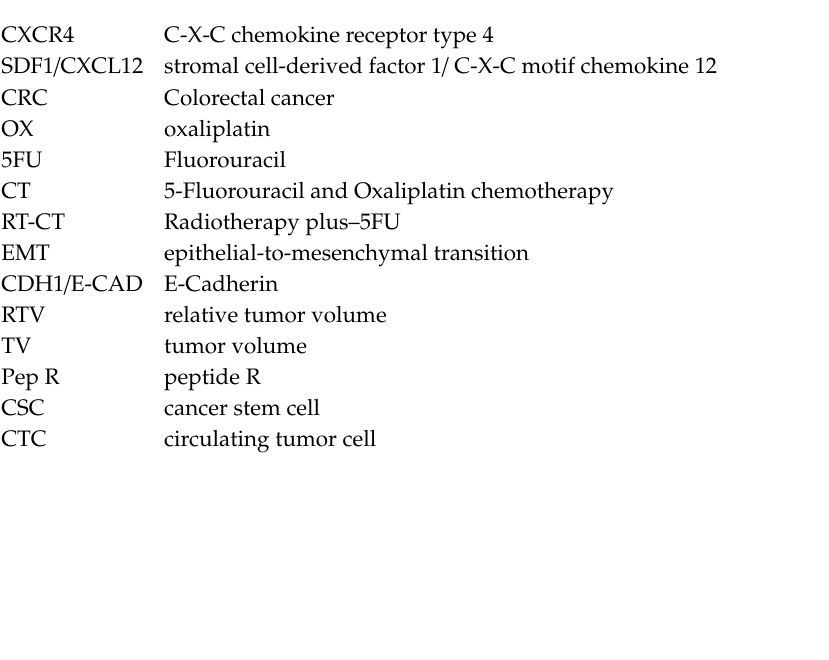
Figure S1: Treatment schedule of standard radiochemotherapy in HCT116 human colon xenograft, Figure S2: 18 F-FDG uptake decreased in 5-FU-RT treated tumors and in Pep R treated tumors, Figure S3: CXCR4 expression increased in tumor xenografts compared to cells growing in culture, Figure S4: Pep R significantly reduced CXCR4 gene expression, Figure S5: CXCR4 and CXCL12 expression significantly correlates with mesenchymal markers in colorectal cancer, Figure S6: In vivo and in vitro Peptide R modulated 5FU-OX induced PD-L1 in HCT116 human colon cancer, Table S1: Primer sequences for SYBR Green